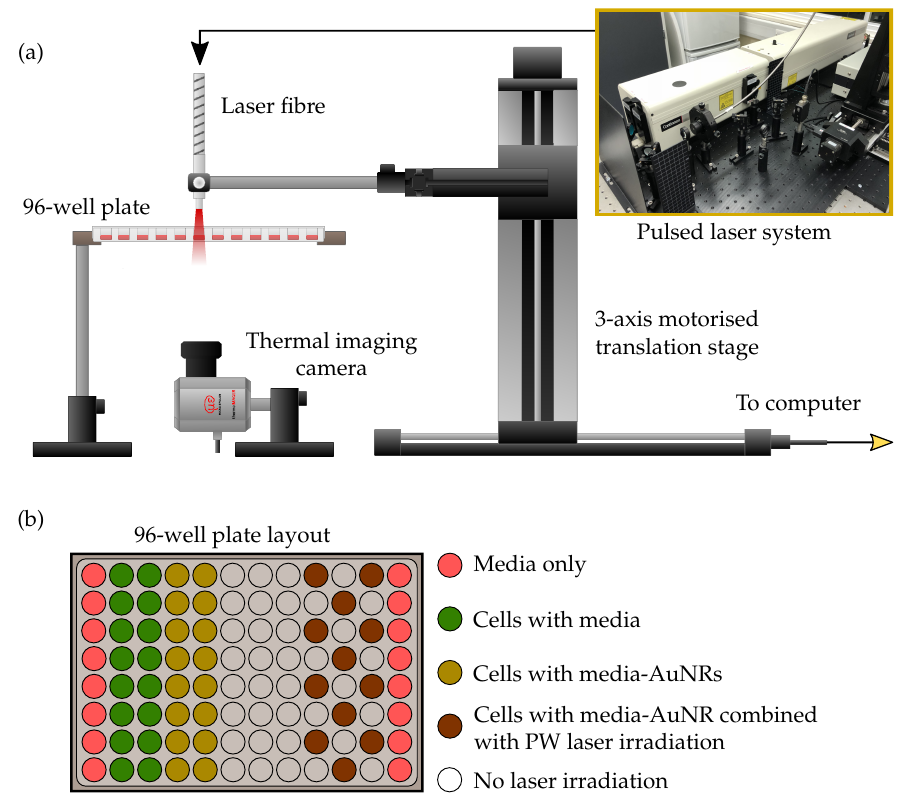
Figure 8. Diagram depicting the PPTT experimental setup. A 96-well plate containing A549 cells with AuNRs is suspended on a platform while a pulsed laser fibre irradiates the wells from above. The fibre is held by a 3-axis motorised translation stage and controlled via a computer interface to scan across the wells. A thermal imaging camera monitors the temperature changes from below. The layout of the 96-well plate is shown above. Wells under laser irradiation were alternated to reduce any potential influences from irradiating adjacent